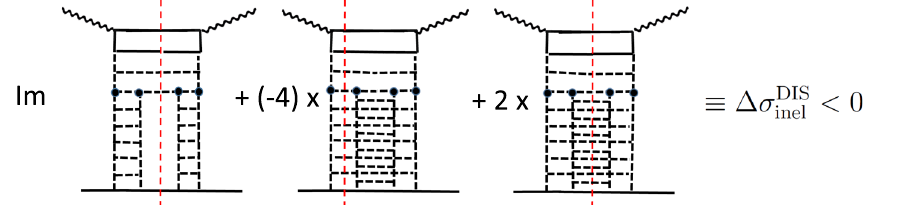
Fig. 2 Thefirstabsorptivecorrectionduetotherescatteringofaninter- mediate parton. The continuous and dashed lines correspond to quarks and gluons respectively. The sum of all possible cuts gives the imagi- nary part of the amplitude. According to the AGK cutting rules [16,17]